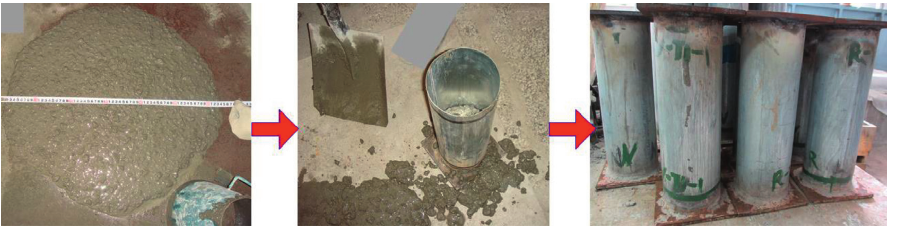
Figure 1: Fabrication process of specimens.